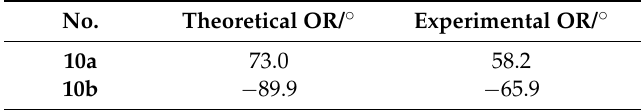
Table 4. The calculated and experimental optical rotation (OR) of 10a and 10b .